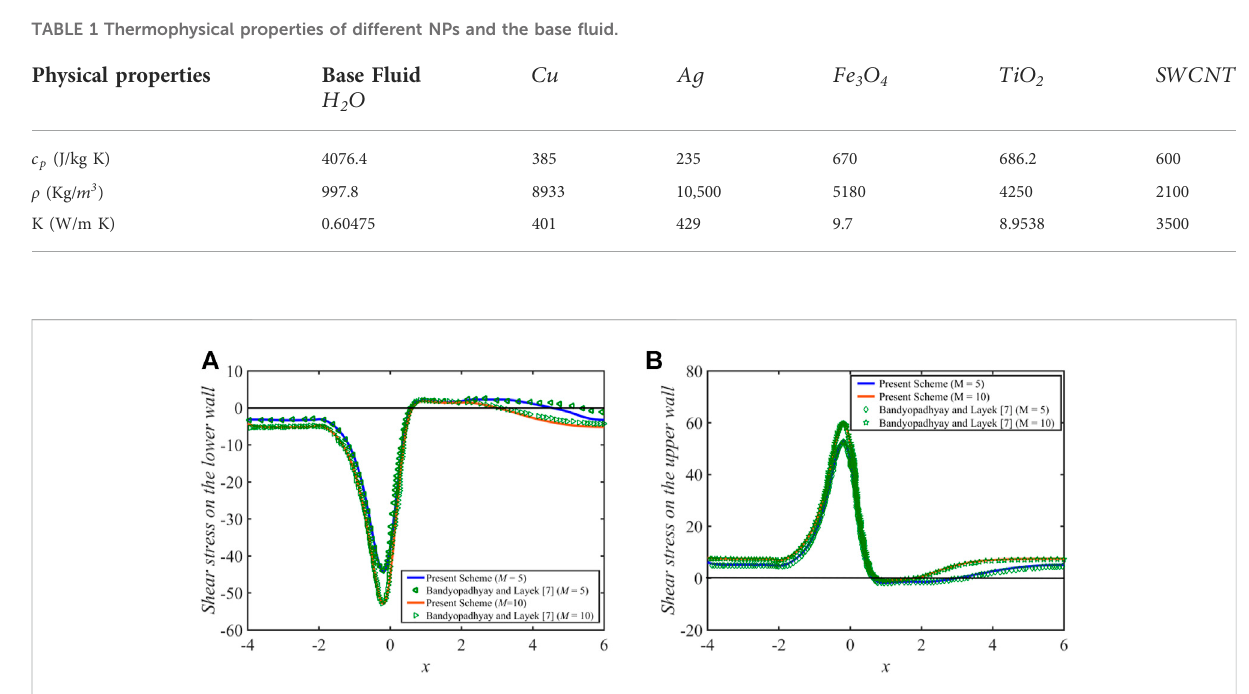
WSS distribution for the pulsatile fl ow, for M (cid:2) 5 , 10 , at Re (cid:2) 700 , h1 (cid:2) h2 (cid:2) 0 . 35 , St (cid:2) 0 . 02 , and t (cid:2) 0 . 25